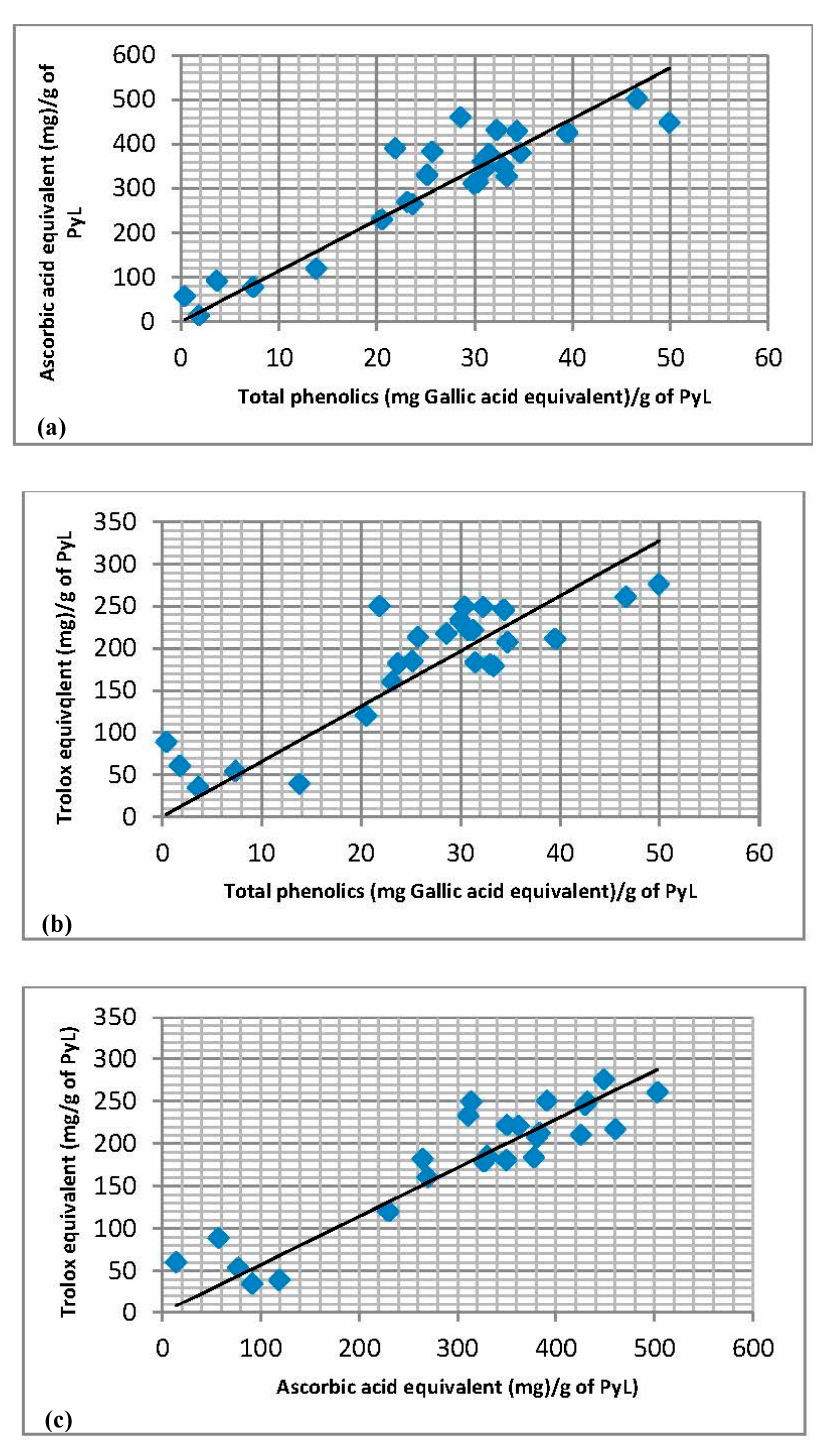
Figure 5. Correlation between antioxidant assays and total phenolics content of pyrolytic lignins (PyL), ( a ) DPPH versus TPC, ( r = 0.8663, p < 0.0001); ( b ) TEAC versus TPC ( r = 0.8044, p < 0.0001); and ( c ) DPPH versus TEAC ( r = 0.8851, p < 0.0001). Product moment correlation was performed using CoStat (version 6.4).